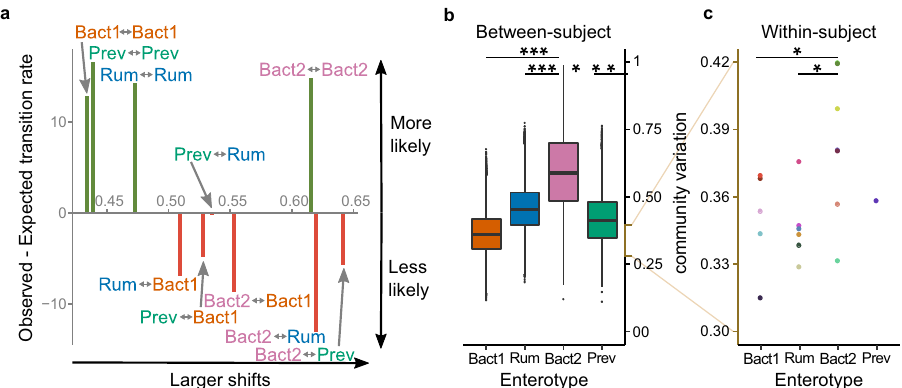
Fig. 6 Bact2 enterotype assignment is as stable over time as other enterotypes despite higher between- and within- subject community variation. a For all enterotype switches, discrepancies between expected and observed switching rates (standardized residuals of a Chi Square goodness of fi t test with 10 categories for all possible enterotype switches, P = 2 × 10 − 16 ) ( y -axis), were set out against community variation (median BC dissimilarity of the constellation using all applicable samples in the study cohort, N = 20, n = 694) ( x -axis). b Between-subject community variation per enterotype, calculated as the BC dissimilarity between samples of different individuals of the same enterotype within the FGFP cohort ( N = 1103; N = 401,331,186,185 for the Bacteroides1 (B 1 ), Ruminococcaceae (R), Bacteroides2 (B 2 ), and Prevotella (P) enterotypes, respectively). Between-subject community variation is signi fi cantly higher in Bact2 versus all other enterotypes (ANOVA on multivariate homogeneity of group dispersions on BC dissimilarities between individuals across enterotypes, N = 1103, Q < 10 − 29 for all comparisons with Bact2). c Within-subject community variation per enterotype, calculated as the median BC dissimilarity between all samples of an individual enterotyped as Bact1, Rum, Bact2, or Prev for the majority of their samples ( N = 19, excluding participant 808). Within-subject community variation is signi fi cantly higher in Bact2 versus Bact1 and Rum enterotypes (Dunn test, two-sided, N = 19, P = 0.0392, and P = 0.0096, respectively). The body of the box plots represents the fi rst and third quartiles of the distribution, and the median line. Whiskers extend from the quartiles to the last data point within 1.5×IQR, with outliers beyond. Signi fi cance levels: ***: 0.001, **: 0.01, *: